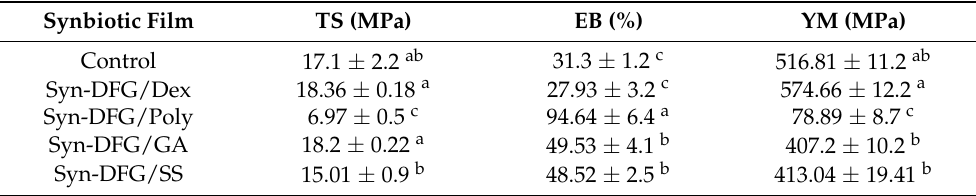
Table 5. Mechanical properties including of tensile strength (TS), elongation at break (EB), and Young’s modulus (YM) of synbiotic DFG films.